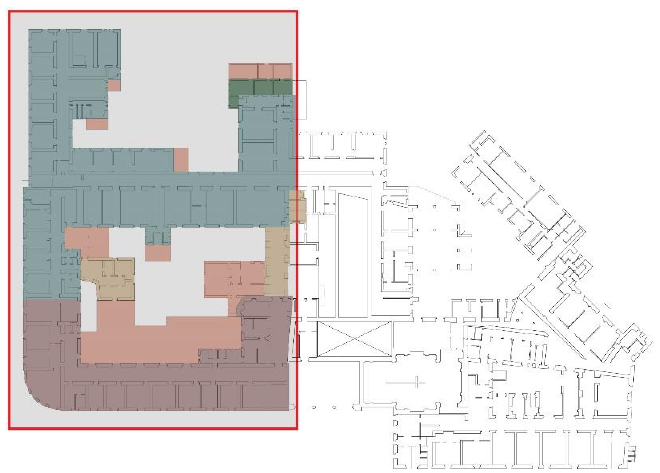
Figure 5. Extension carried out between 1931 and 1939.